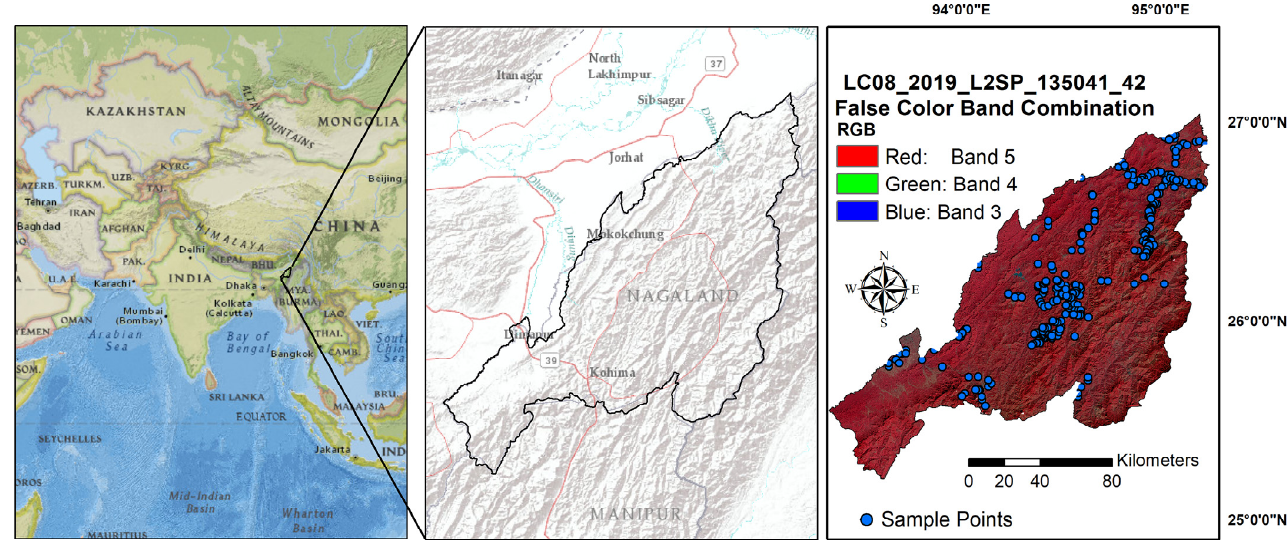
Figure 1. The study site location and sampling points shown on a Landsat 8 OLI satellite